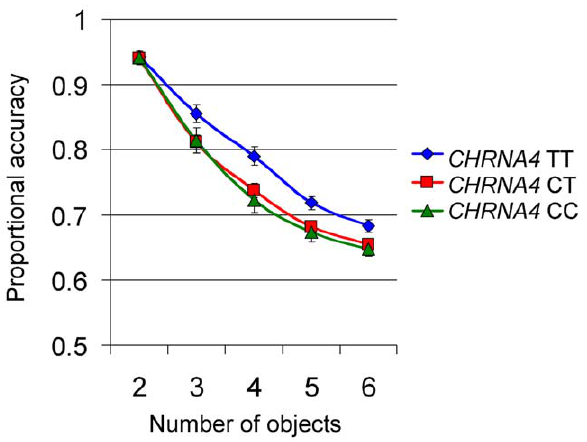
Figure 3. Proportional accuracy on the multiple accuracy task for each of the CHRNA4 genotype groups over load conditions. Error bars represent standard error of the mean.